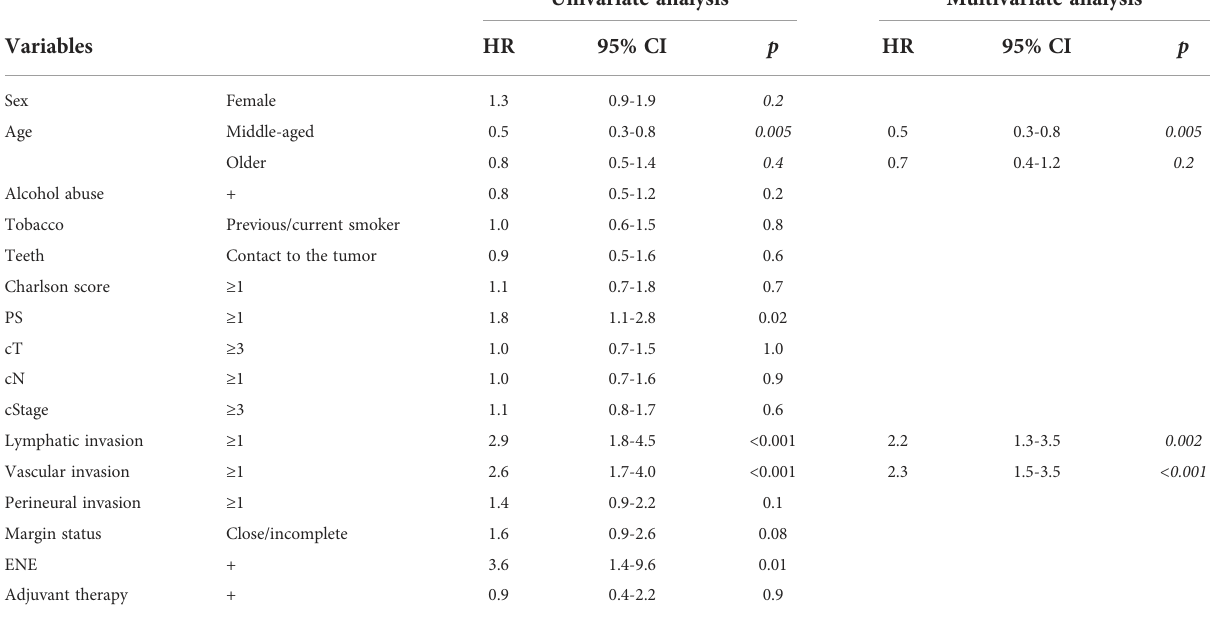
TABLE 2 Univariate and multivariate Cox regression models for DFS. Univariate analysis Multivariate